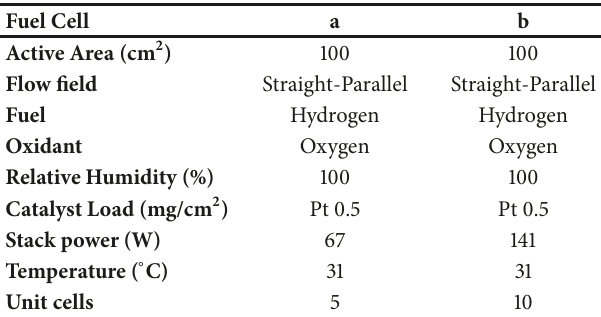
Table 2: Construction and operational parameters of fuel cells presented in Figure